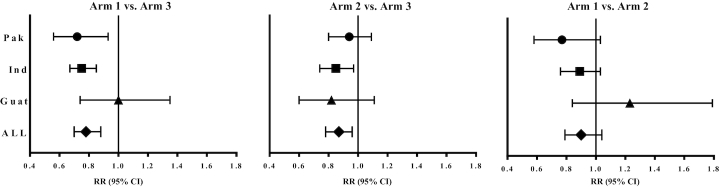
RRs and 95% CIs for pairwise comparisons of SGA by treatment arm, by site, and for combined sites (31). RRs with corresponding 95% CIs comparing proportions of SGA for the pairwise comparisons are obtained from generalized linear models with generalized estimating equations to estimate parameters while controlling for cluster correlations. For combined data, models are adjusted for country. Women First newborn measurements based on those with gestational age data. "All" comprised combined data from Pak, Ind, and Guat. Sample sizes for each arm within a site ranged as follows: n = 141–160 (Pak), n = 158–184 (Ind), n = 156–177 (Guat), and n = 459–517 (All). Guat, Guatemala; Ind, India; Pak, Pakistan; SGA, small for gestational age.